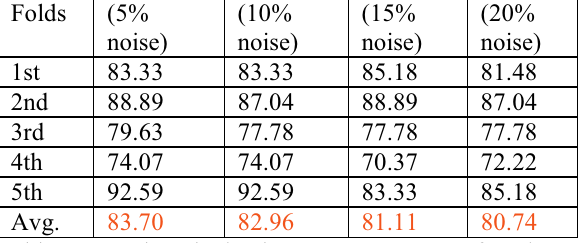
Table 5: Results Obtained From DE-FLANN for Pima Dataset